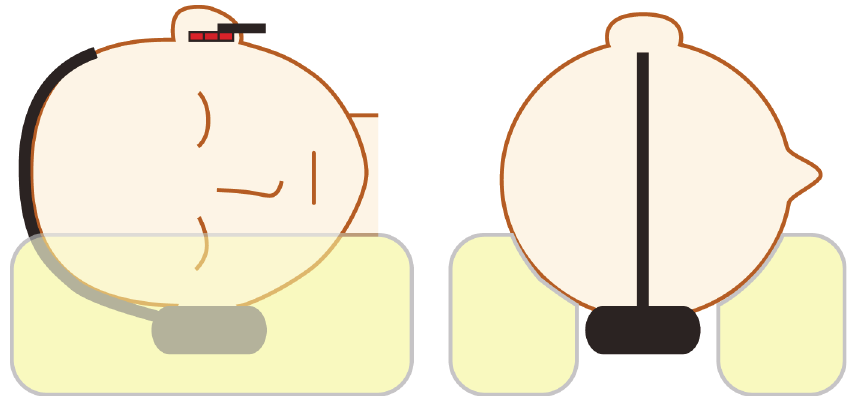
Fig 2. Subject ’ s head condition during the measurements. The subject ’ s head was fixed in the condition of the entrance of the ear canal facing up to the ceiling. The pillow had the space which enabled a masker earphone to be worn without the interference with the